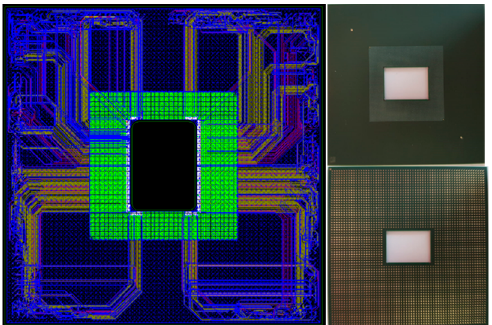
Figure 20. The package design showing the RF routing (left) and the actual substrate front and back sides (right) showing the bump area and the BGA matrix as well as the cutout hole.